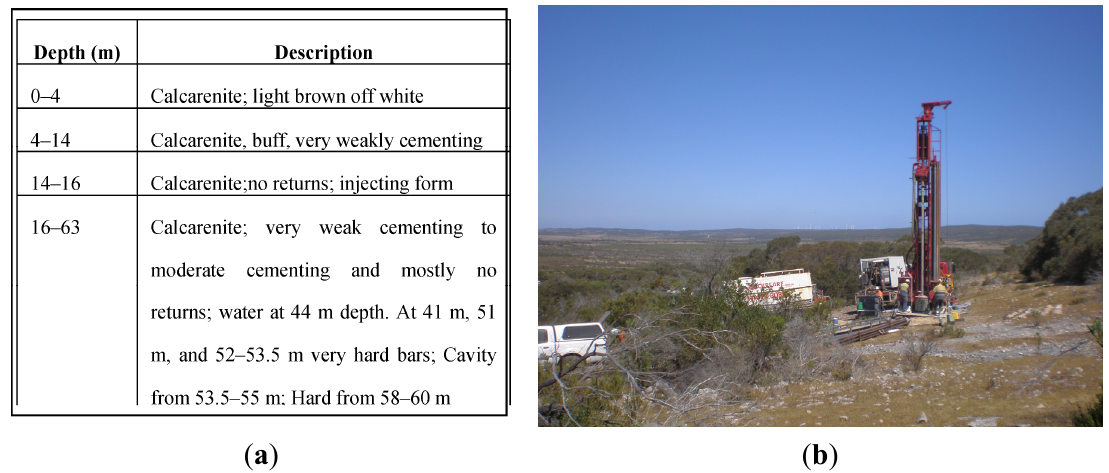
Figure 2. Section of the coastal cliff.